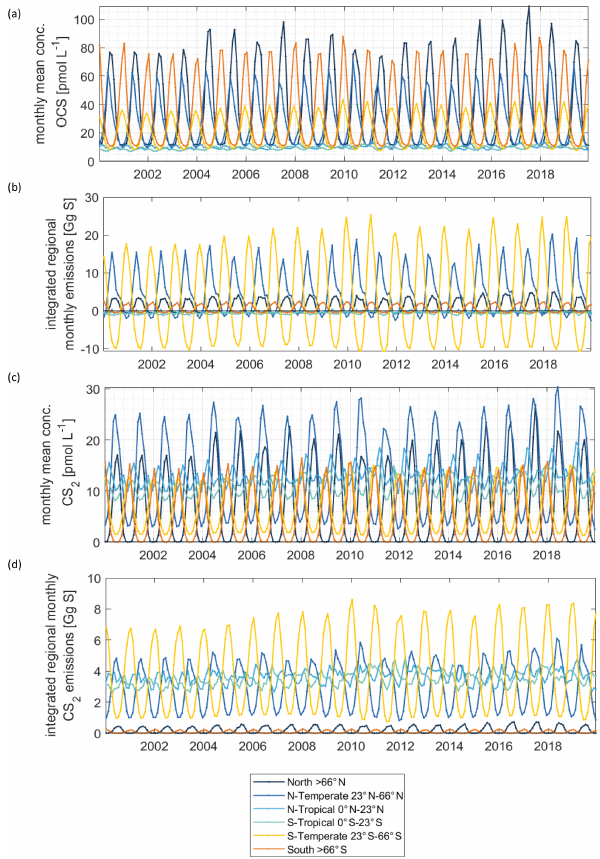
Figure 4. Regionally resolved interannual variability in concentra- tions (a) and emissions (b) for OCS. Same in (c) and (d) for CS 2